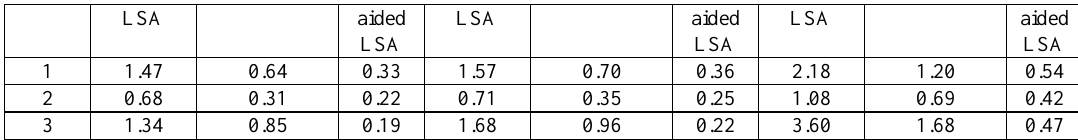
Table 2. The planimetric coordinate residuals of check points before and after correction (units ： m)